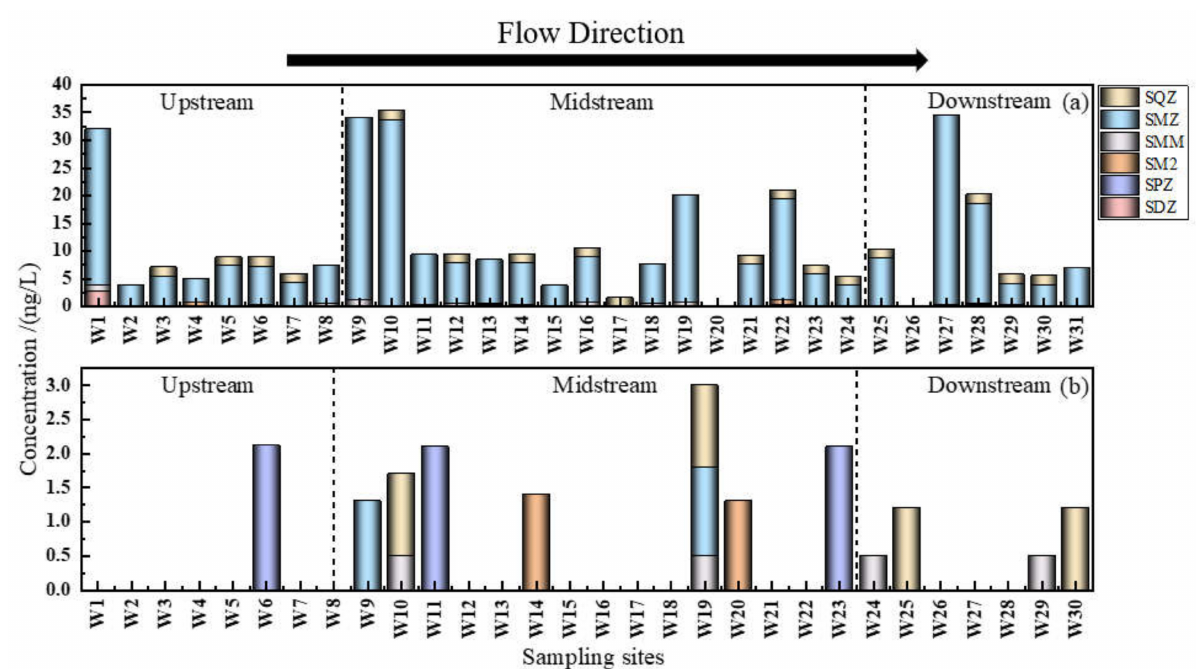
Figure 5. Distribution of SAs in the Shaanxi section of the Weihe River: ( a ) the wet water period; ( b ) the flat water